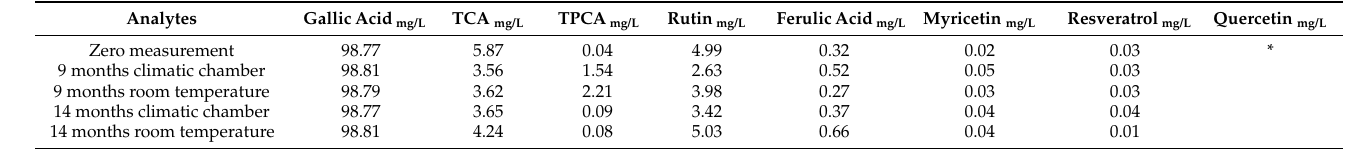
Table 16. Biologically active substances . Sample F—Pinot noir sweet, harvest 2016.